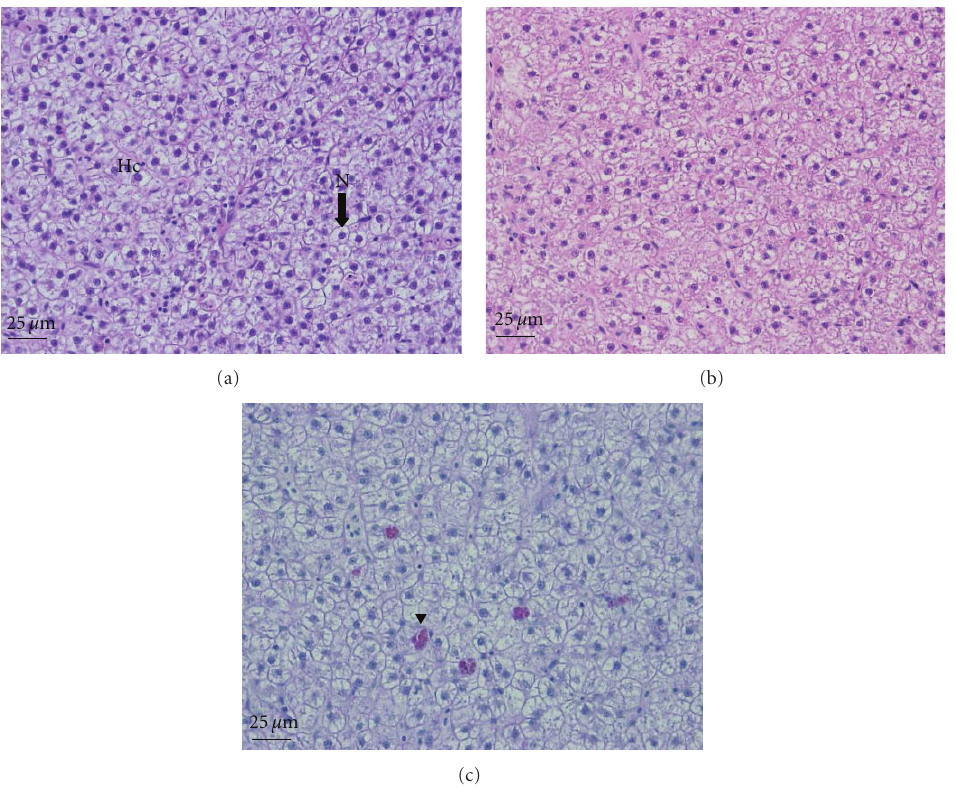
Figure 7: Histological changes in the liver of the common carp ( Cyprinus carpio ) exposed to Ag-NPs for 96 h. (a) Control. AB-PAS (pH 2.5). (b) 100 µ g/L. Atrophy of the hepatocyte nucleus. H&E stain. (c) 200 µ g/L. Accumulation of eosinophilic granules (arrow head). AB-PAS (pH 2.5). Hc: hepatocyte, N: